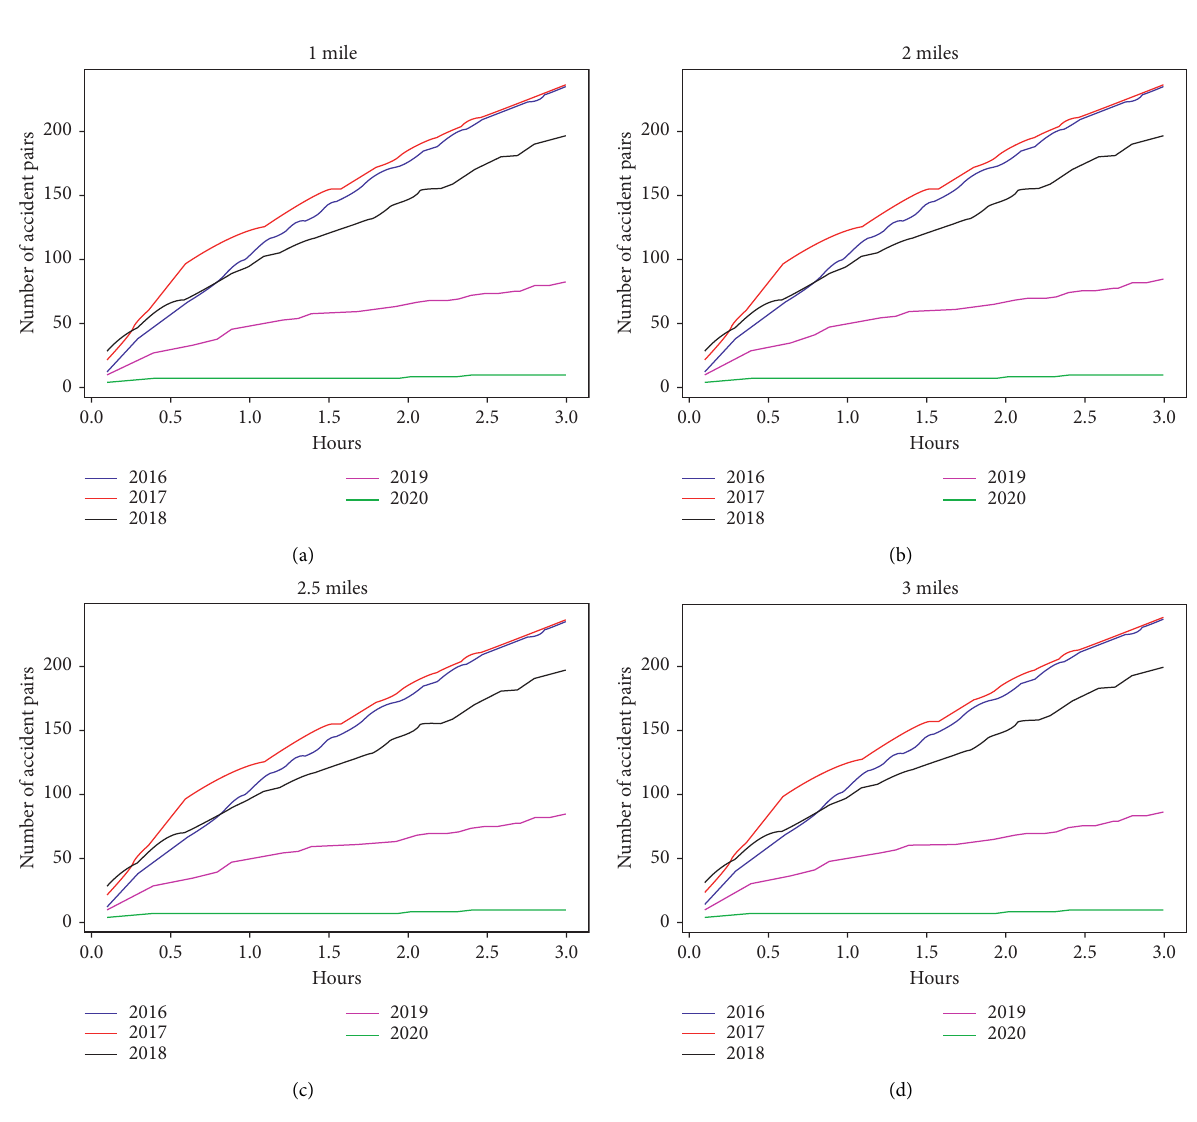
Figure 5: Time threshold sensitivity